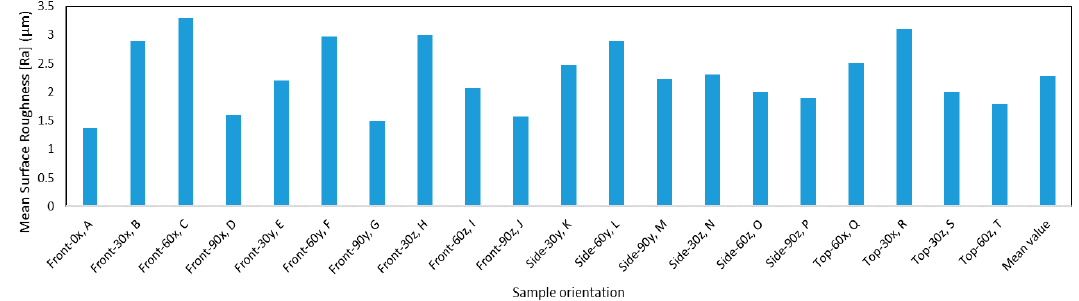
Figure 9. The mean surface roughness for the different orientations.